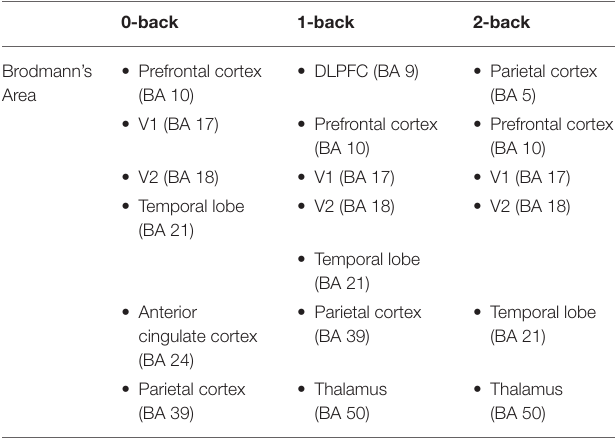
Dotted vertical lines indicate events of interest (the button-press) and horizontal blue lines denote 15 Hz frequencies. On